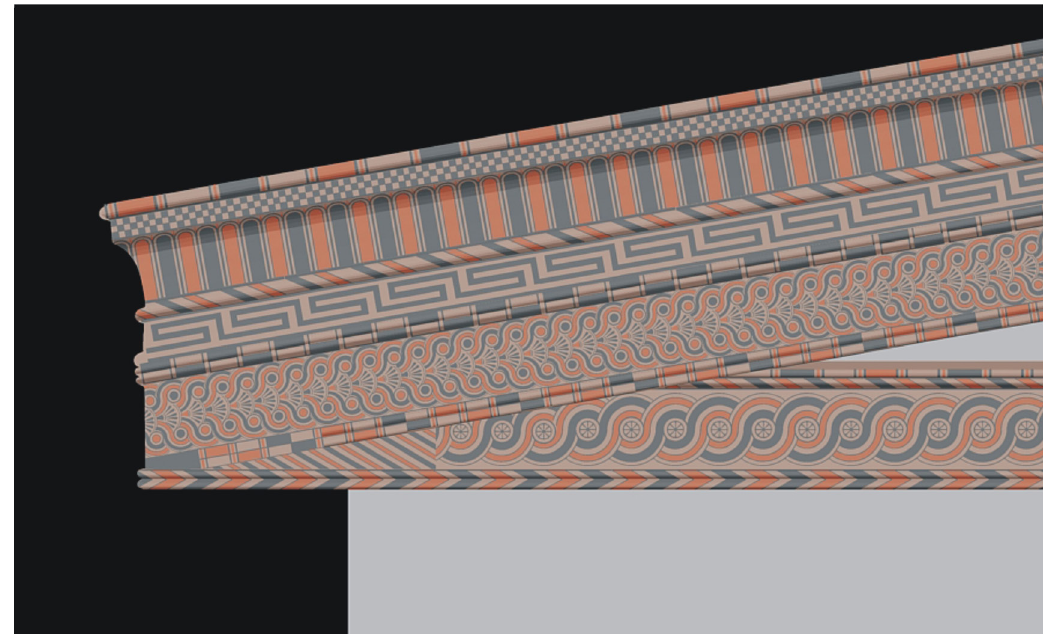
Figure 7. Tempietto H. CAD reconstruction of the roof corner (Jari